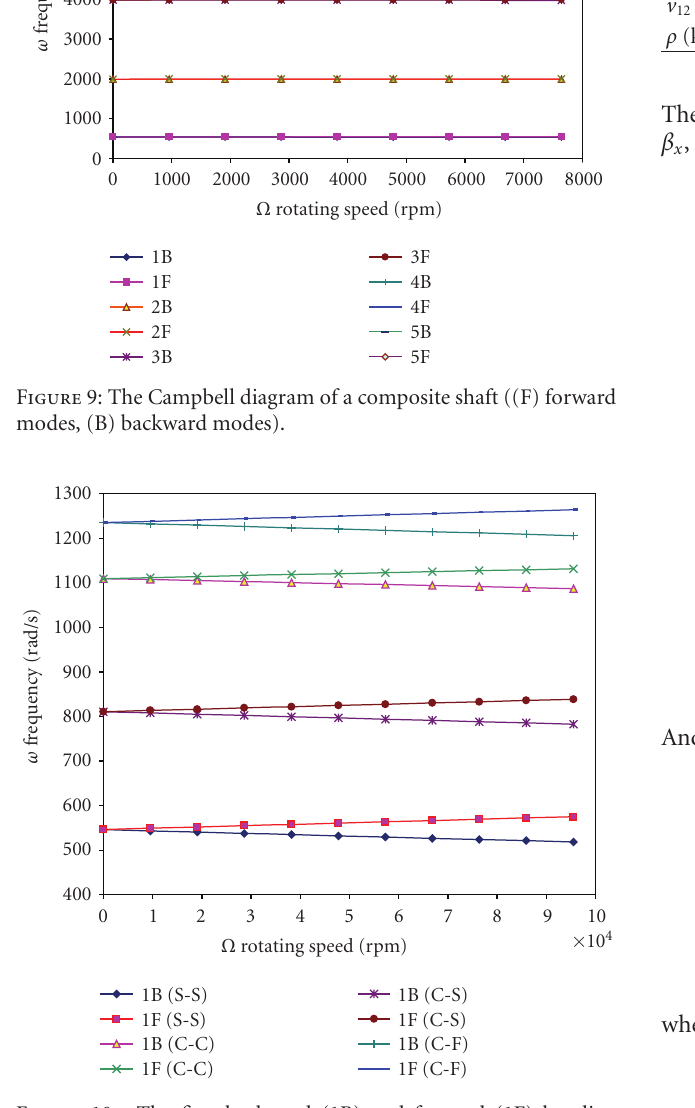
Figure 10: The first backward (1B) and forward (1F) bending mode of a composite shaft for di ff erent boundary conditions and di ff erent rotating speeds (S: simply supported; C: clamped; F: free).